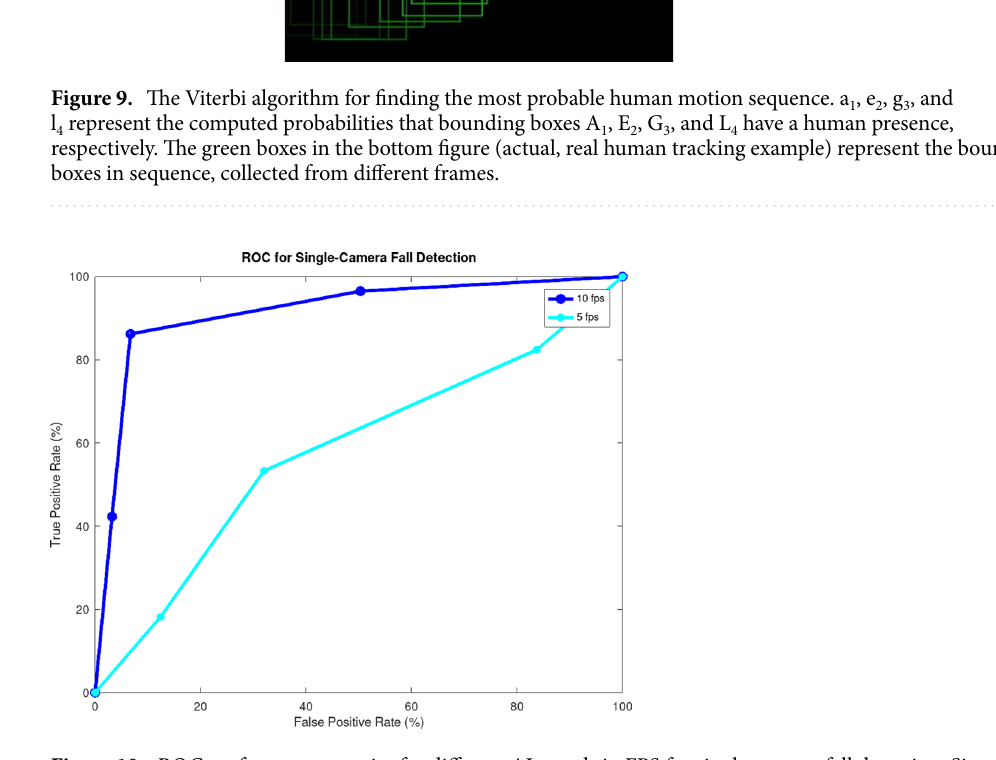
Figure 10. ROC performance metrics for different AI speeds in FPS for single-camera fall detection. Simply making AI faster, while all else being equal, has significant benefits on the overall